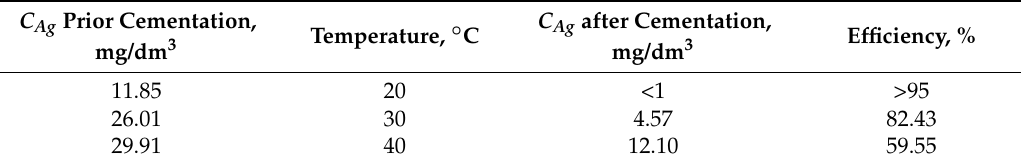
Table 6. Degree of Ag cementation by Cu powder.